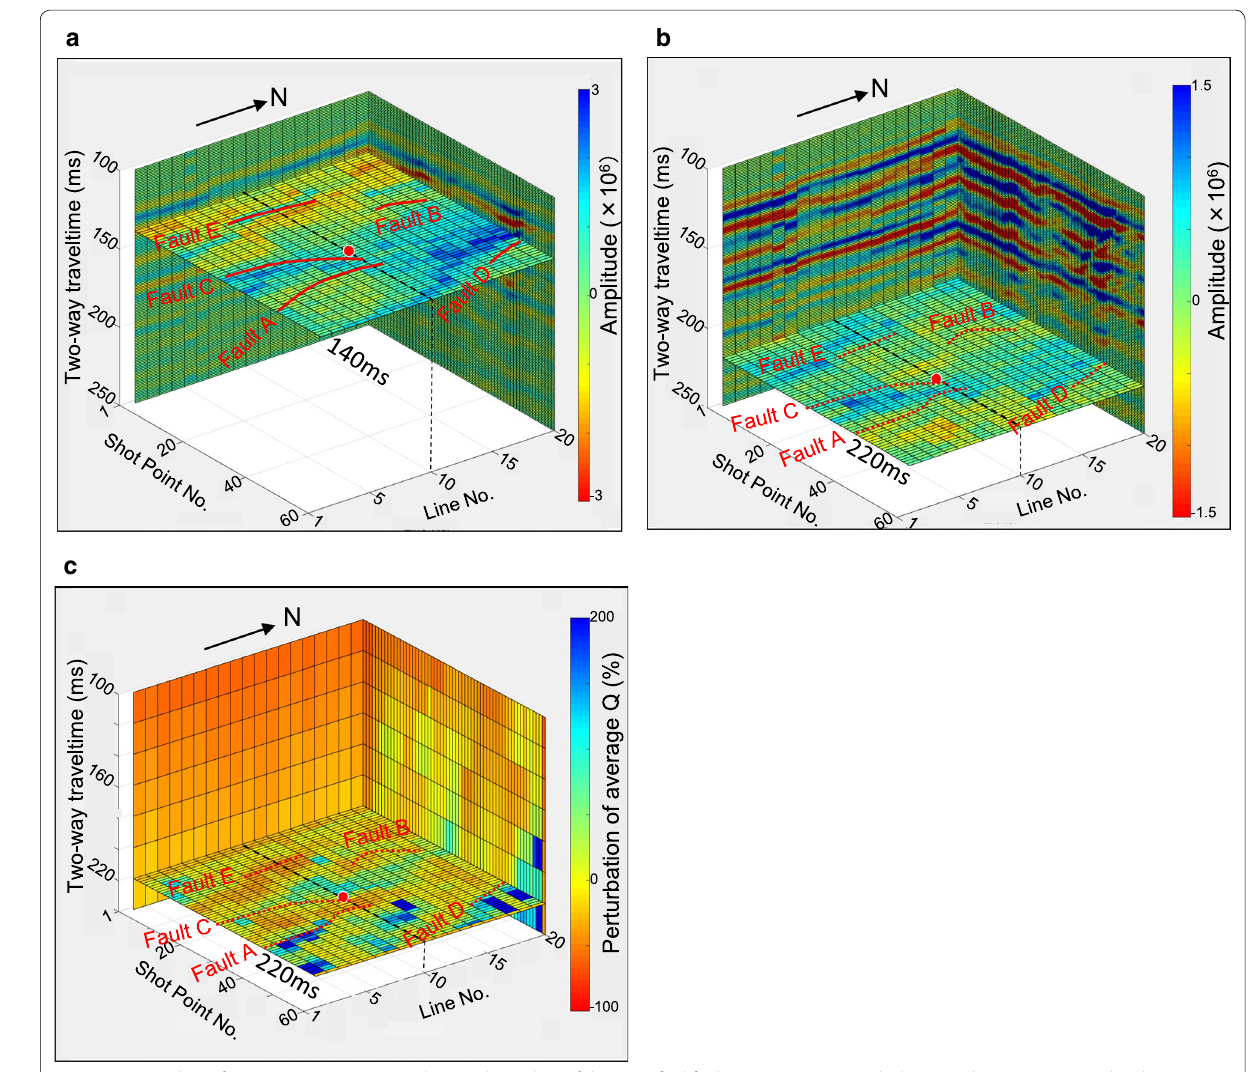
Fig. 3 a Time slice of 140 ms in two‑way travel time. The strikes of the specified faults are consistent with the spatial variation in amplitude. A red circle marks the location of the most obvious EWF. b Time slice at 220 ms. The fault strike seems to be consistent with the spatial variation in amplitude but is somewhat difficult to see. c Q slice at 220 ms. The fault strikes seem to be consistent with a high‑attenuation anomaly (red‑to‑yellow colors), especially between Faults A and